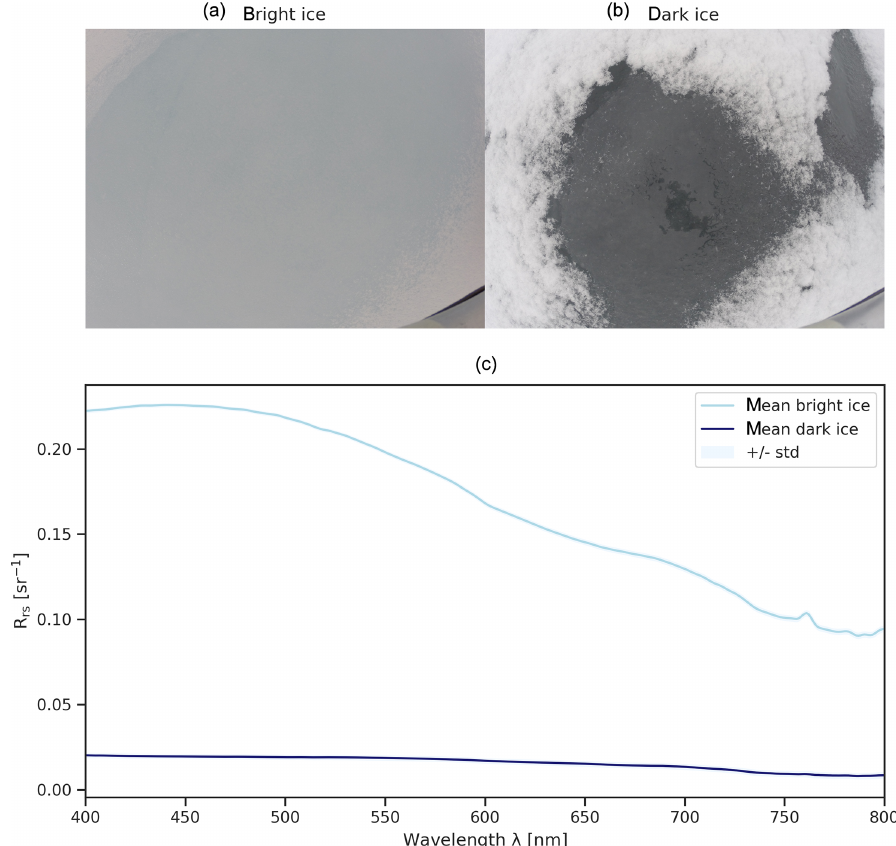
Figure 1. Photos of bright (a) and dark (b) bare ice surfaces and respective reflectance spectra (c) . We took the photos from approximately 50cm (a) and 30cm (b) above the surface.